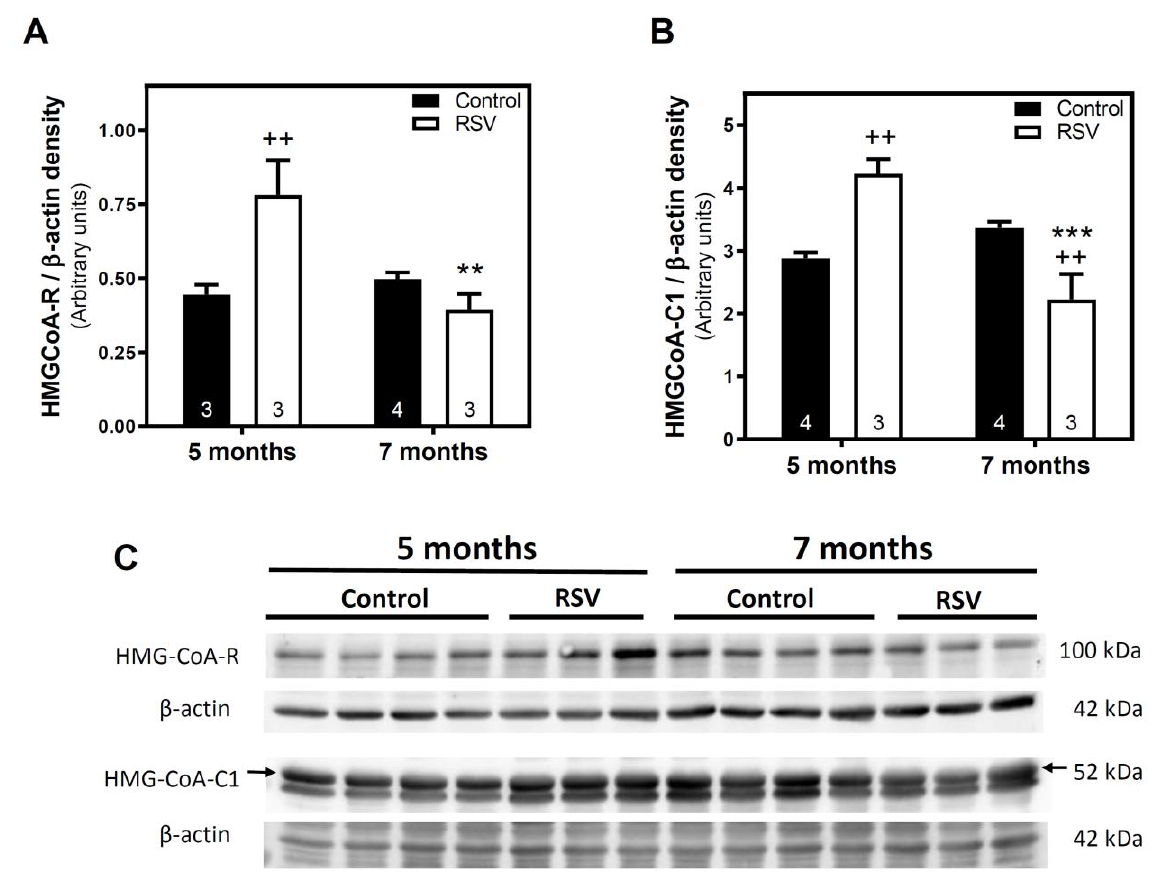
Figure 4. Analysis of the endogenous cholesterol synthesis in the brain of SAMP8 mice. Key enzymes in the de novo synthesis of cholesterol such as HMG-CoA reductase ( A ) and HMG-CoA-C1 synthase ( B ) were detected and quantified by Western blotting ( C ) in the cytosolic fraction. β -actin was used as a gel loading control. Data are the mean ± SEM of the indicated different samples. Two-way ANOVA and a Sidak test for multiple comparisons were applied. ** p < 0.01 and *** p < 0.001: significantly different from the corresponding 5 mo value; ++ p < 0.01: significantly different from the corresponding control group.